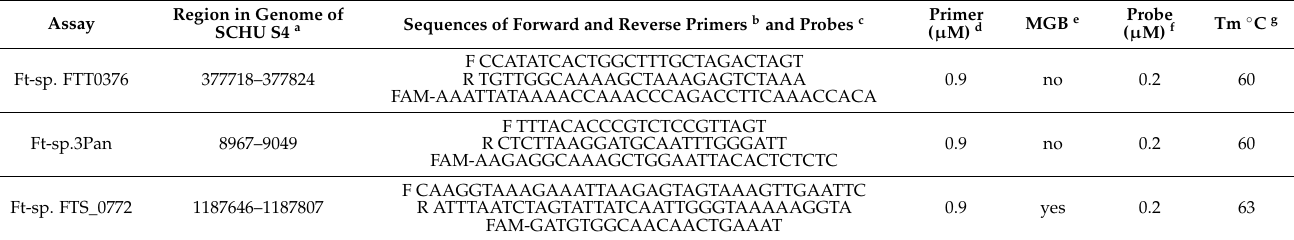
Table 1. Primers and TagMan-MGB probes for real-time assays targeting F. tularensis . Assay Region in Genome of SCHU S4 a Sequences of Forward and Reverse Primers b and Probes